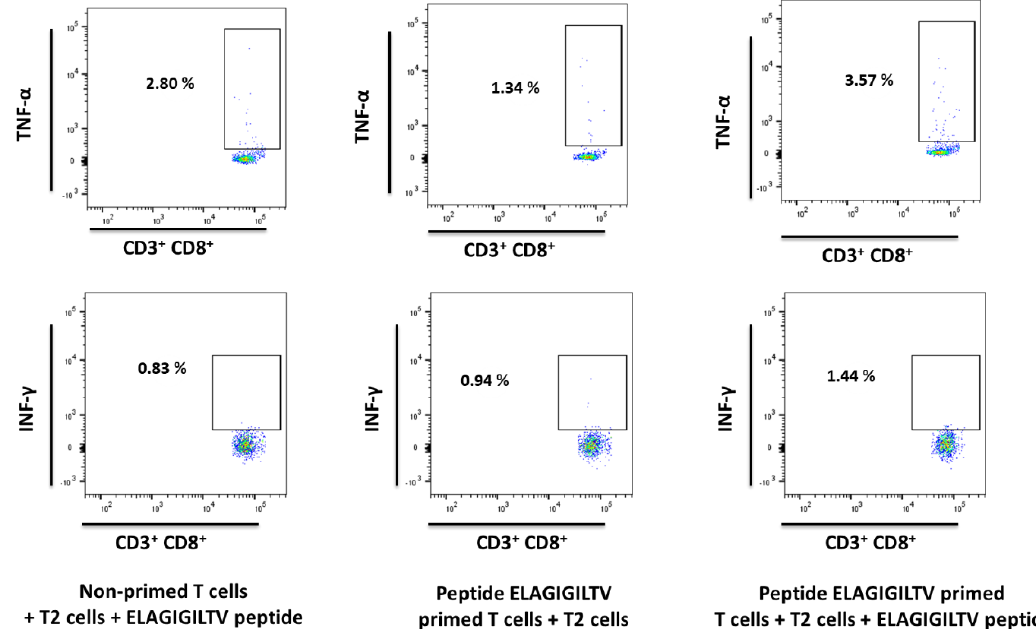
Figure 7. Intracellular flow cytometry staining (HD 3026, E:T ratio 1:10) primed with peptide ELAGIGILTV. The ability of ELAGIGILTV-specific CD8 + T cells to secrete the cytokines IFN- γ and TNF- α after stimulation was evaluated by intracellular flow cytometry staining. Exemplary flow cytometry plots of positive responses are shown. T cells were gated on CD3 + CD8 + cells.